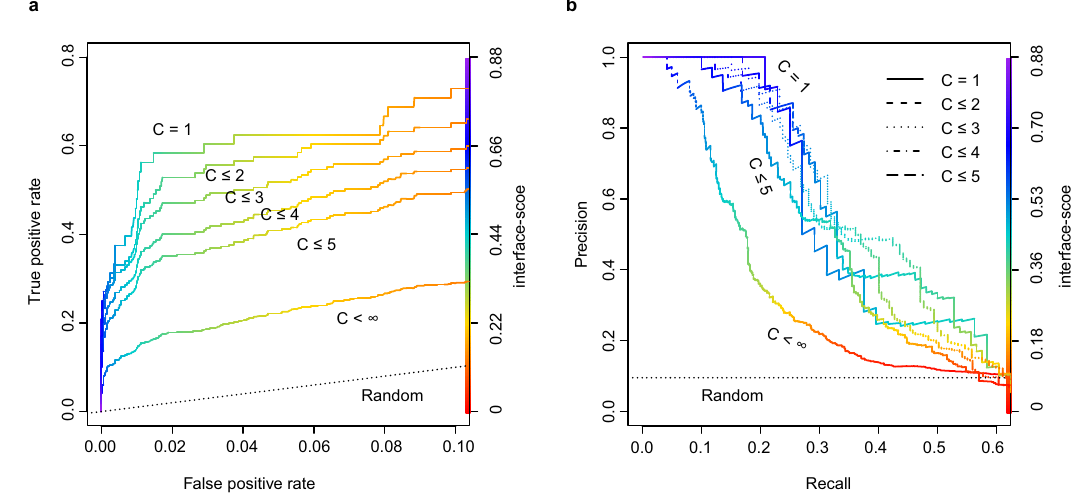
Fig. 5 A large-scale test on the E. coli proteome suggests that many pairs previously thought to interact directly are likely in assemblies of components that are not necessarily in direct contact. The interface-score was used as the varying metric to derive the ( a ) ROC curve and ( b ) the precision-recall curve. For a dimer target, C is de fi ned by the maximum of the appearances of its two monomers in this data